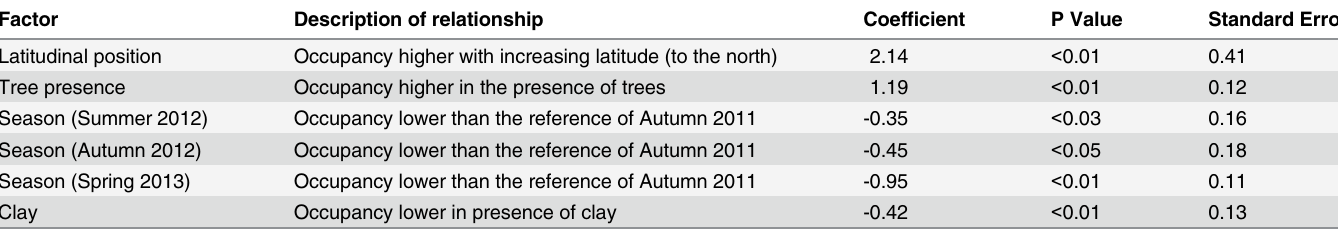
Table 3. Description of terms in the parsimonious model of occupancy